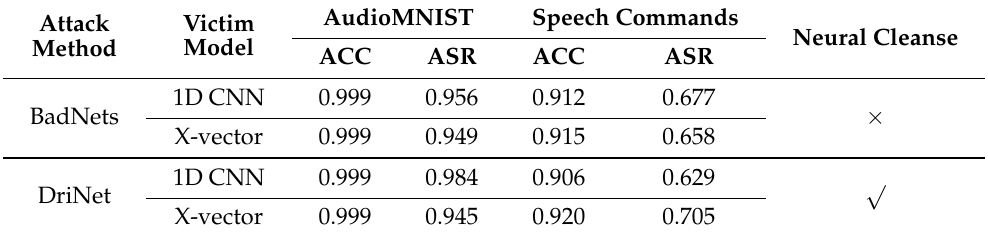
Table 5. The performance comparison between BadNet and DriNet. We let the poisoning rate be 0.01 for the AudioMNIST dataset and 0.1 for the speech commands dataset. “ × ” means cannot bypass the √ defense. “ ” means can bypass the defense.